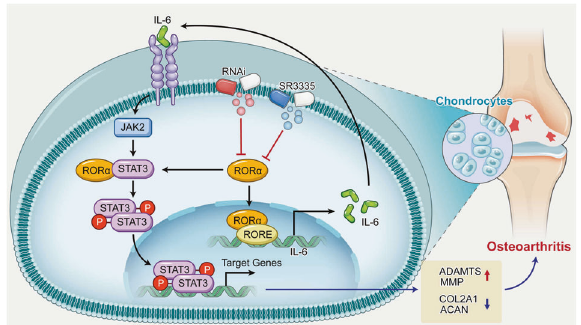
Fig. 8 ROR α blockade inhibited STAT3 phosphorylation and dampened IL-6/STAT3 pathway in chondrocytes of OA. ROR α directly interacts with STAT3 protein or the promoter region of IL6 gene, thereby accelerating the cartilage depredating effect of in fl ammatory cytokine. ROR α blockade with either SR3335 or small interfering RNA resulted in the decreased level of STAT3 phosphor- ylation, and subsequently restored the expression of aggrecan, collagen type II, MMP, and ADAMTS. Finally, ROR α blockade ameliorated the progression of cartilage